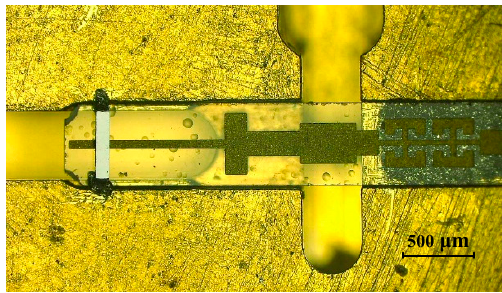
Figure 9. The image of the 135–190 GHz doubler imbedded in the split-waveguide